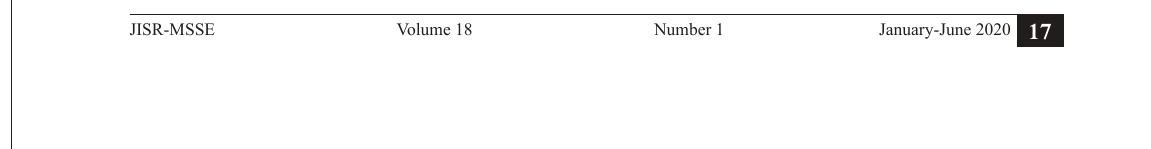
Figure 1: Theoretical Framework (Path Diagram)